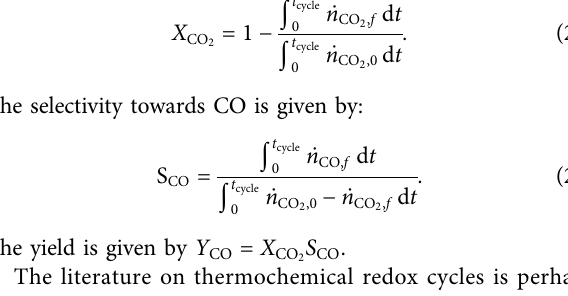
Frontiers in Energy Research |